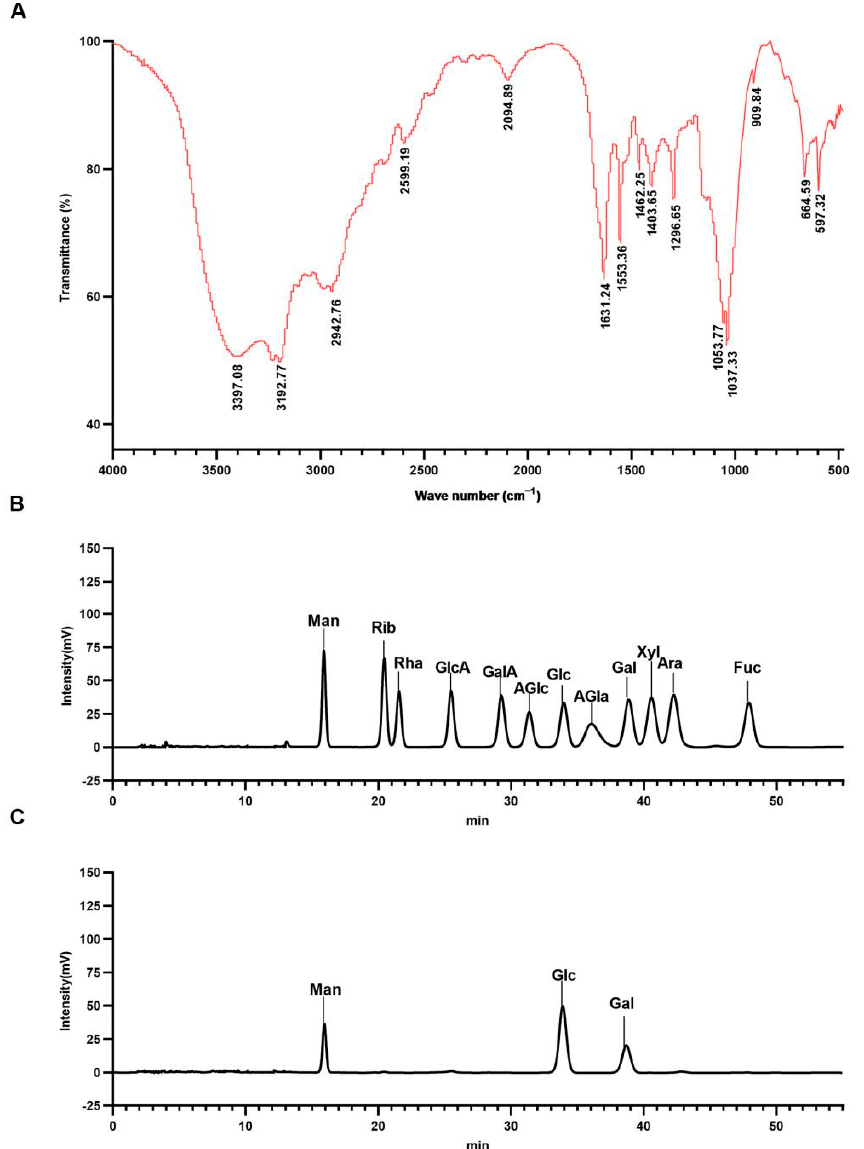
Figure 2. Main organic functional groups and monosaccharide composition of WCP. ( A ) The main organic functional groups in WCP were detected by the FT-IR spectrum. ( B , C ) LC analysis of standard monosaccharides and WCP. Man (mannose); Rib (ribose); Rha (rhamnose); GlcA (glucuronic acid); GalA (galacturonic acid); AGlc (n-acetyl-d-glucosamine); Glc (glucose); AGla (n-acetamidogalactose); Gal (galactose); Xyl (xylose); Ara (arabinose); Fuc (fucose).